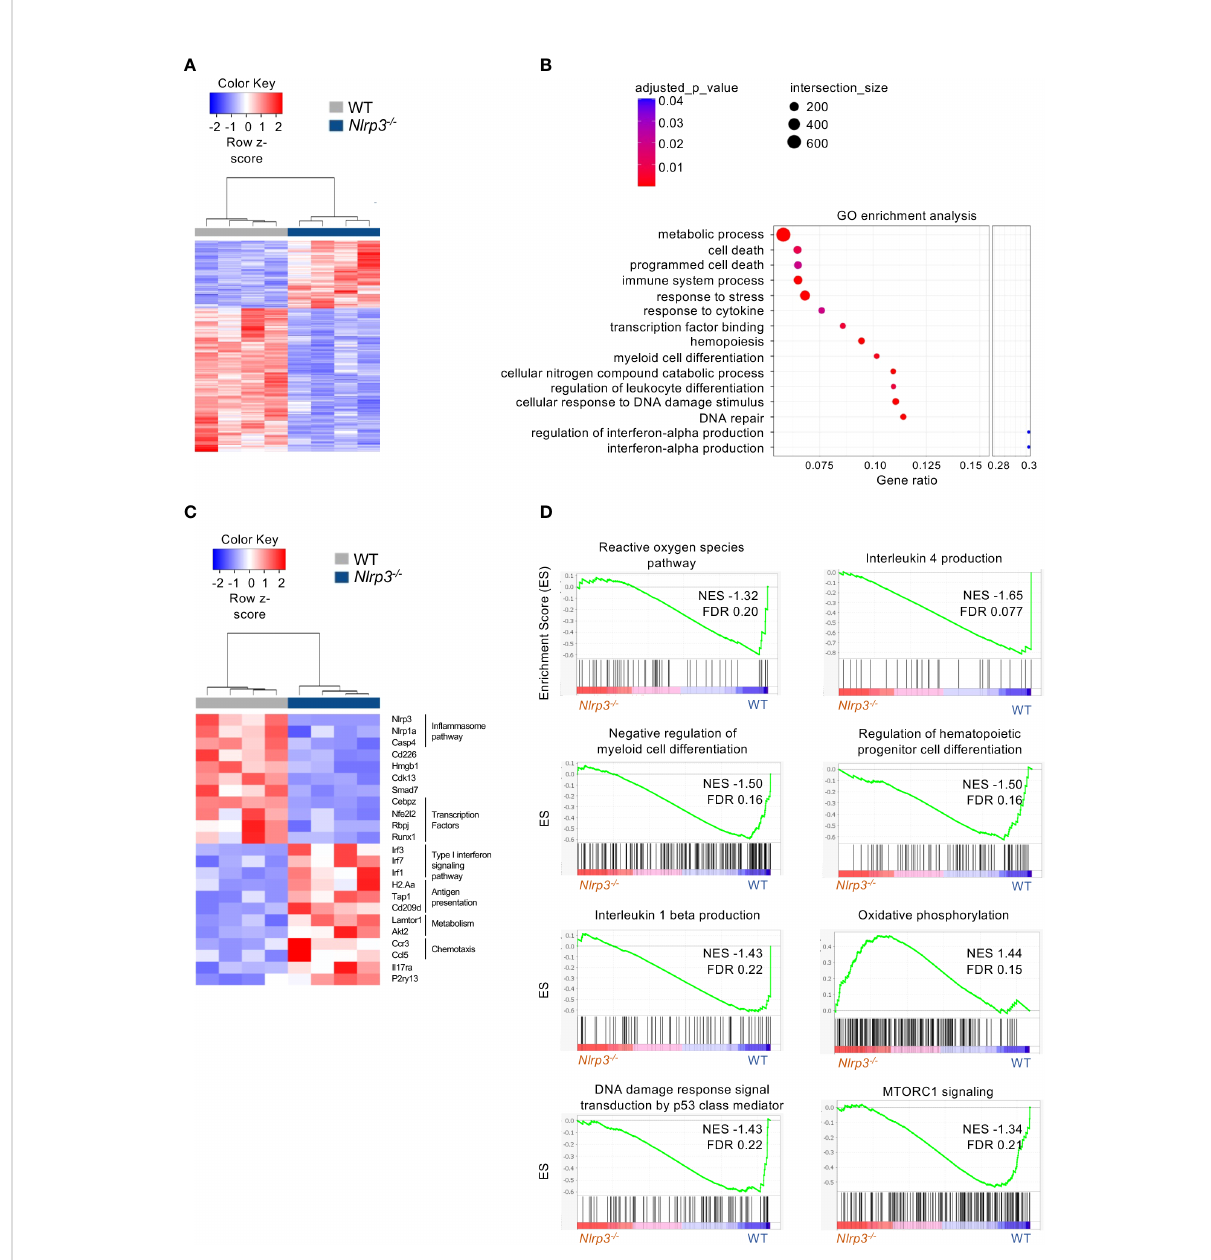
FIGURE 5 Extensive transcriptomic re-programming of Nlrp3 -/- M-MDSCs. (A) Heatmap of DEGs from M-MDSCs from tumor-bearing Nlrp3 -/- ( n = 4) and WT ( n = 4) mice. (B) Pathway analysis of DEGs from Nlrp3 -/- vs. WT. (C) Heatmap of selected DEGs from M-MDSCs from tumor-bearing Nlrp3 -/- and WT mice. (D) GSEA plot showing the enrichment of “ Reactive oxygen species pathway ” (NES − 1.32, FDR 0.20), “ Interleukin 4 production ” (NES − 1.65, FDR 0.077), “ Negative regulation of myeloid cell differentiation ” (NES − 1.50, FDR 0.16), “ Regulation of hematopoietic progenitor cell differentiation ” (NES − 1.50, FDR 0.16), “ Interleukin 1-beta production ” (NES − 1.43, FDR 0.22), “ Oxidative phosphorylation ” (NES 1.44, FDR 0.15), “ DNA damage response signal transduction by p53 class mediator ” (NES − 1.43, FDR 0.22), and “ MTORC1 signaling ” (NES − 1.34, FDR 0.21) gene